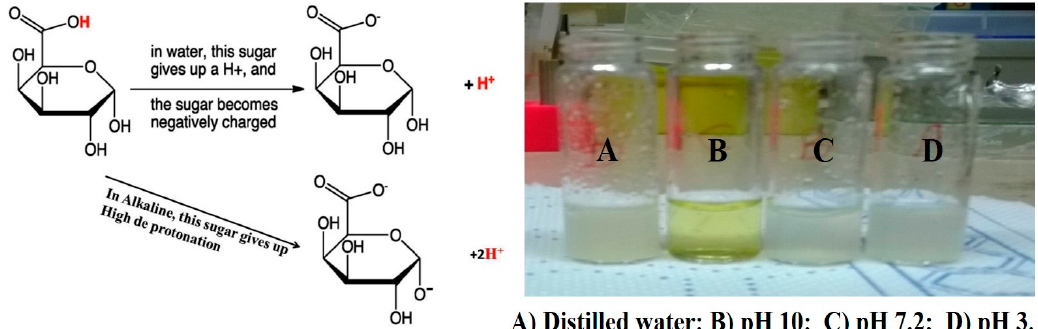
Figure 3. Dissolution of PgA by alkaline solution (figure adapted from [49]).